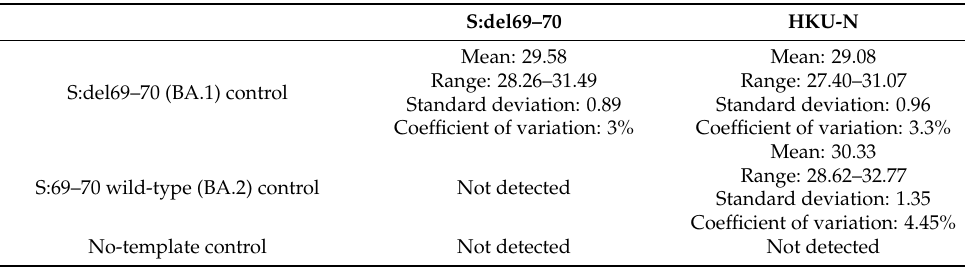
Table 3. Control reproducibility (values represent cycle